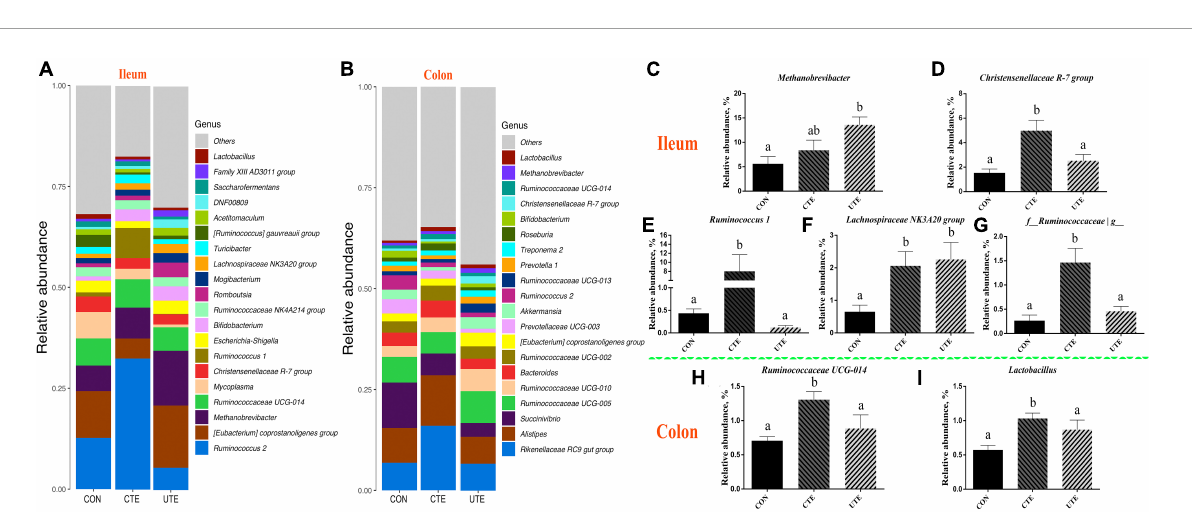
FIGURE7 Effects of coated and uncoated trace elements on the relative abundance of bacteria at genus level. (A) The bacterial composition at genus level in the ileum; (B) the bacterial composition at genus level in the colon; (C–G) bacteria with differences in abundance in the ileum at the phylum level; (H–I) bacteria with differences in abundance in the colon at the phylum level. CON, sheep fed with the basal diets; CTE, sheep fed with the basal diets plus 400 mg/kg coated trace elements; UTE, sheep fed with the basal diets plus an equal amount of trace elements in